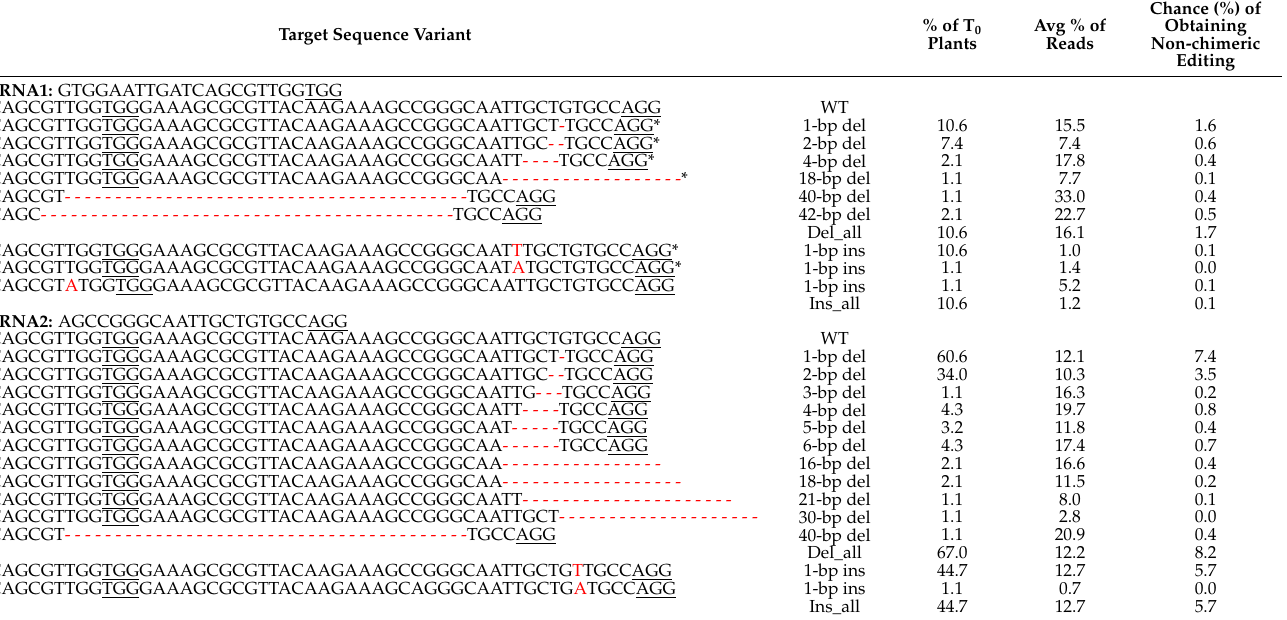
Summary of PCR amplicon sequences from 73 gusA edited H-tobacco